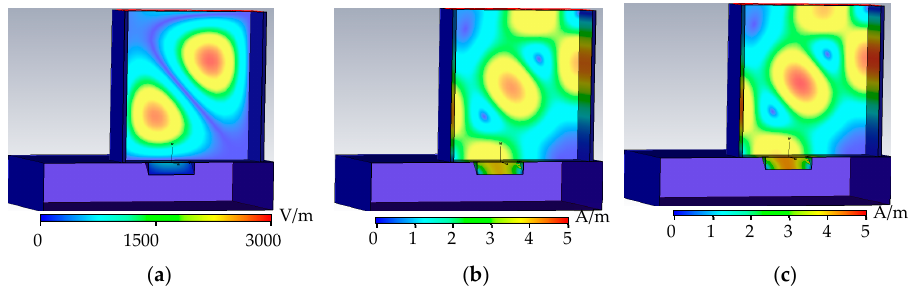
Figure 5. Triangular defect field distribution. ( a ) Triangular prism defect electric field distribution. ( b ) Triangular prism defect magnetic field distribution. ( c ) Triangular prism defect wall current distribution.